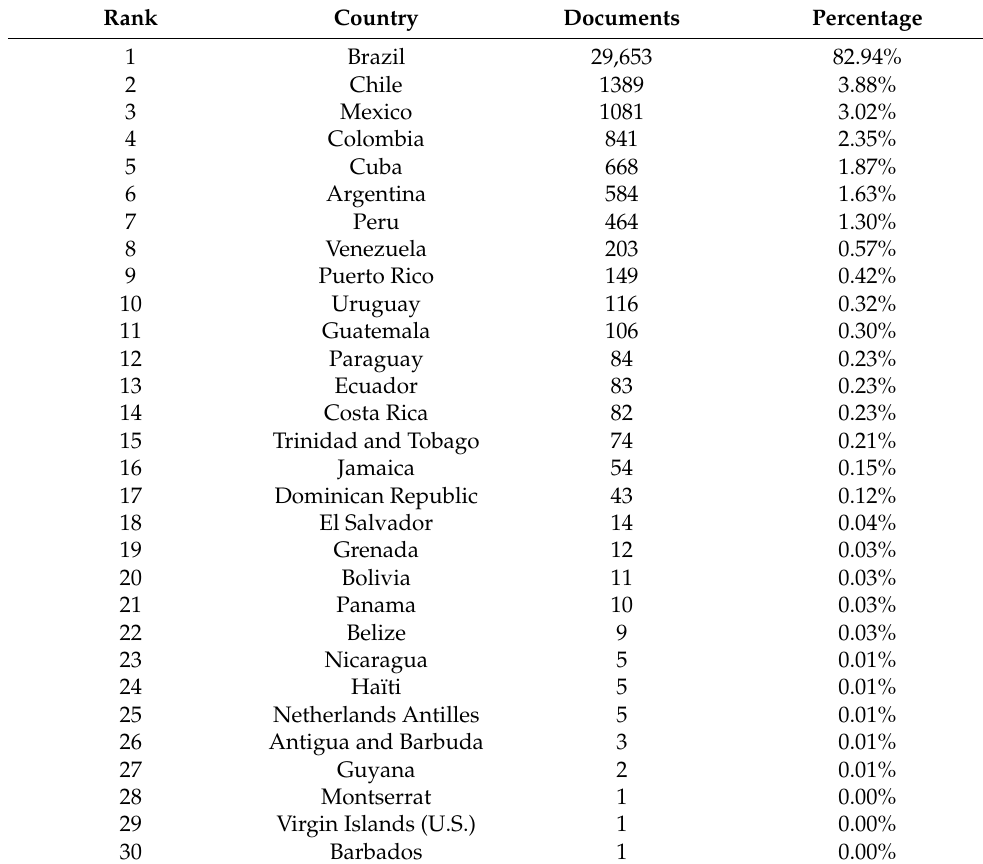
Table 1. Latin American countries with the highest number of publications (1996-2020).